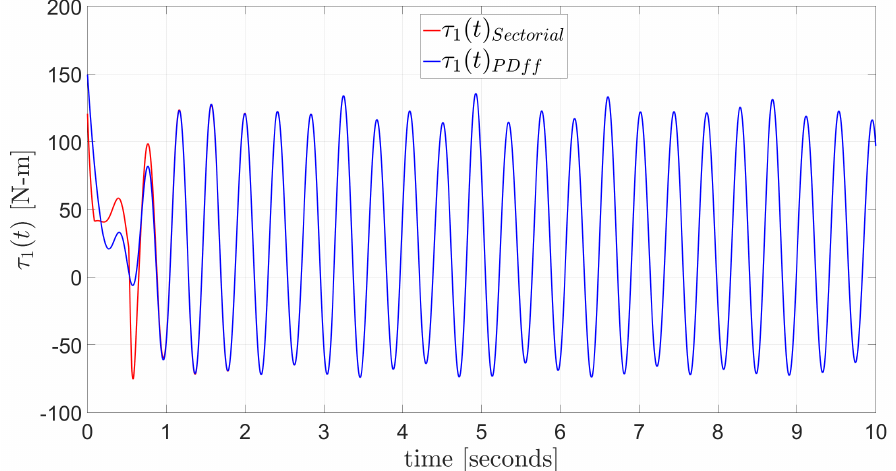
Figure 17. Applied torque to joint 1, without Coulomb friction.